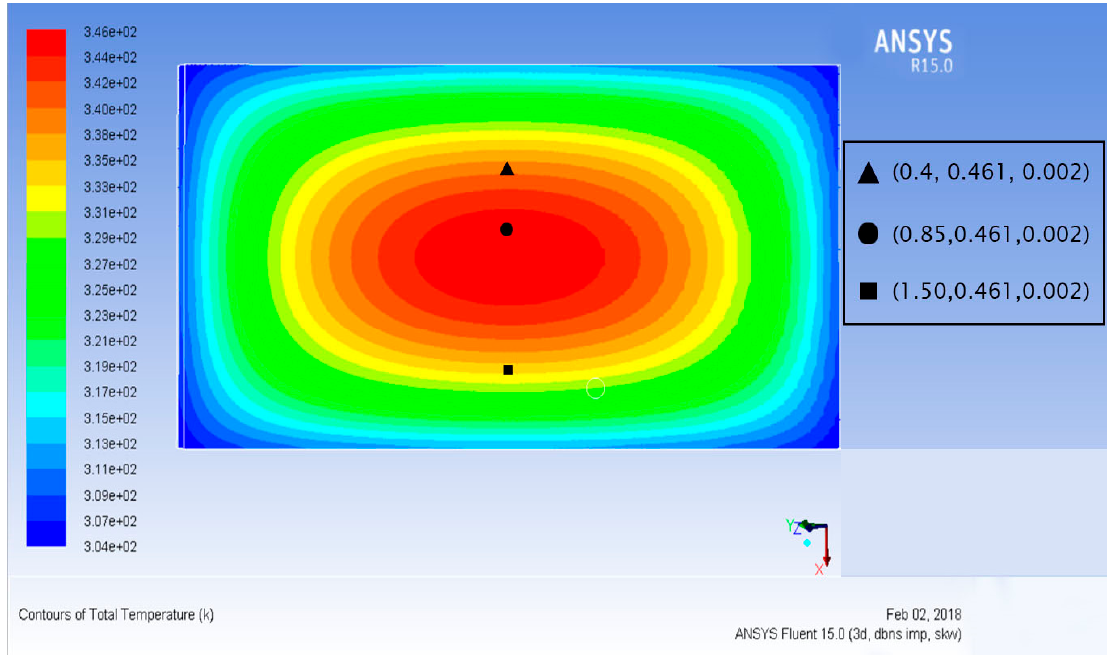
Figure 8. Temperature contours of the upper face of the solar panel.